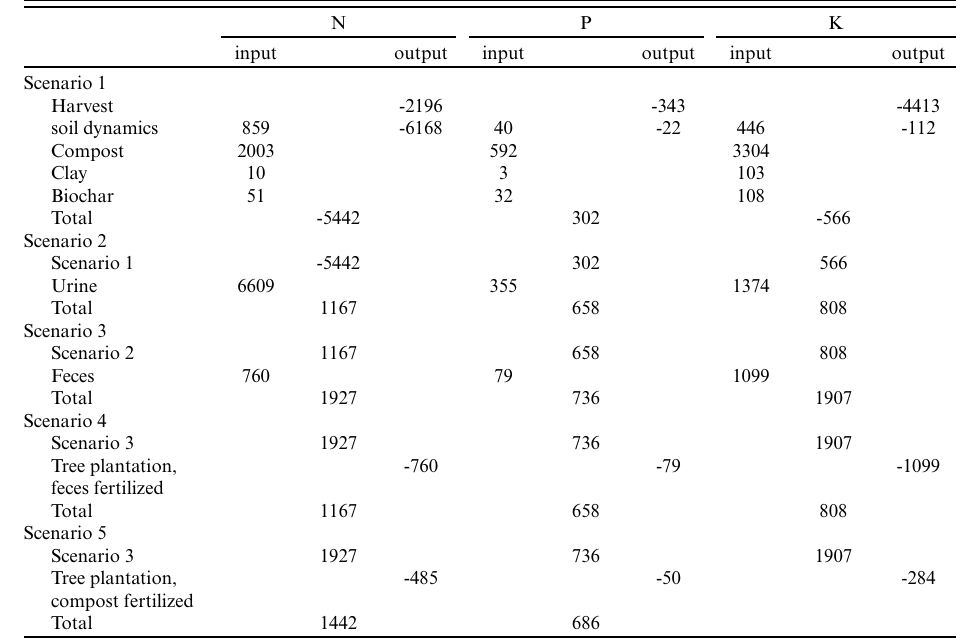
Table 6 . Nutrient cycling balance of all scenarios [g/capita a ⁻